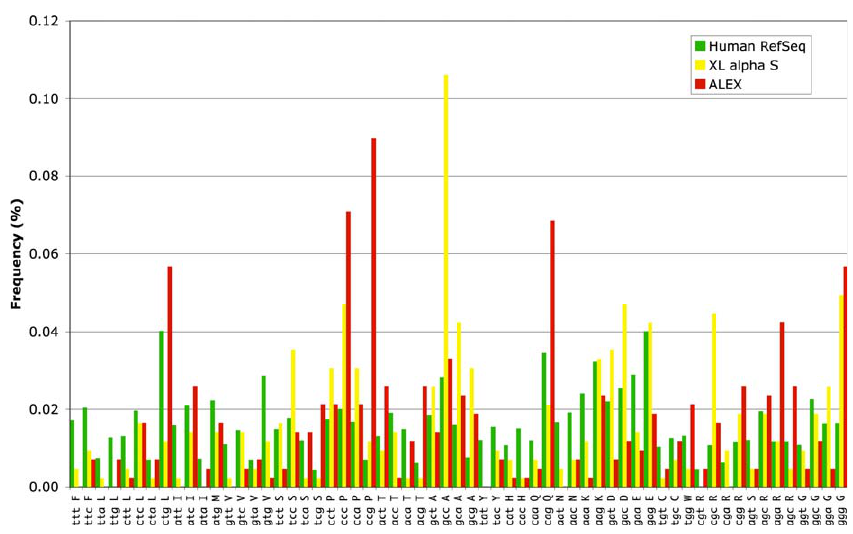
Figure 3. Codon Usage Estimated from Human RefSeq Genes, XL a s Coding Region, and ALEX Coding Region Green indicates human RefSeq genes, yellow indicates XL a s coding region, and red indicates ALEX coding region. DOI: